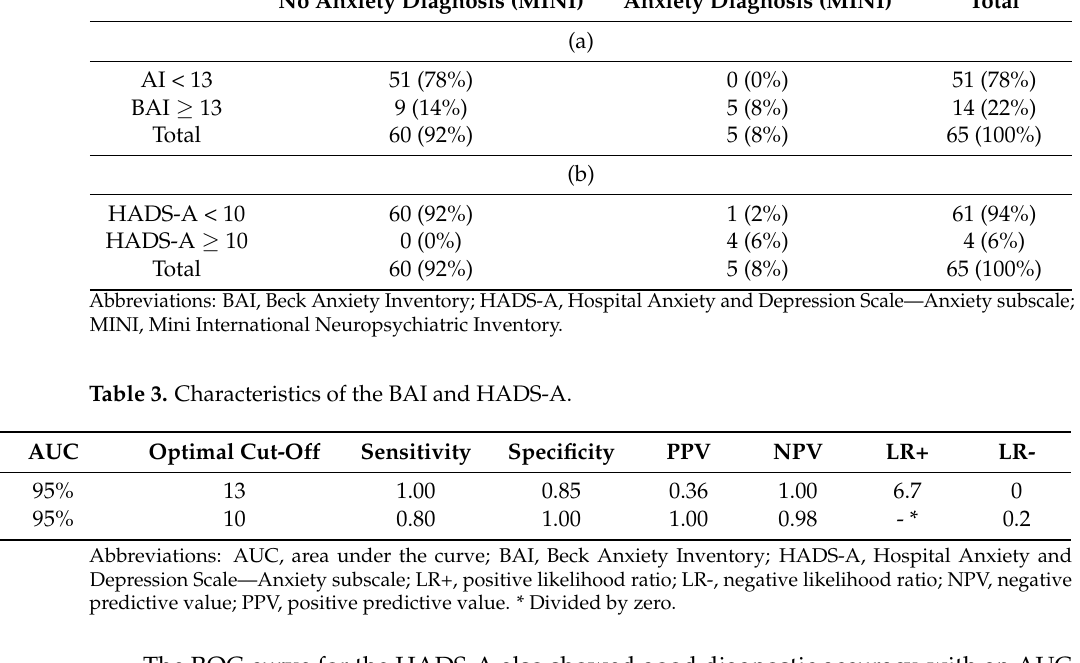
Table 2. (a) Cross-tabulation of the BAI according to the results of the MINI. (b) Cross-tabulation of the HADS-A according to the results of the MINI. No Anxiety Diagnosis (MINI) Anxiety Diagnosis (MINI)